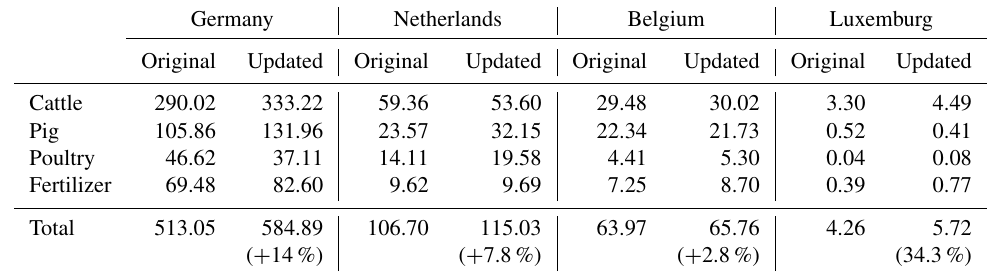
Table 1. NH 3 emission country totals (Ggyr − 1 ) for all agricultural categories and cattle, pig, poultry, and mineral fertilizer in